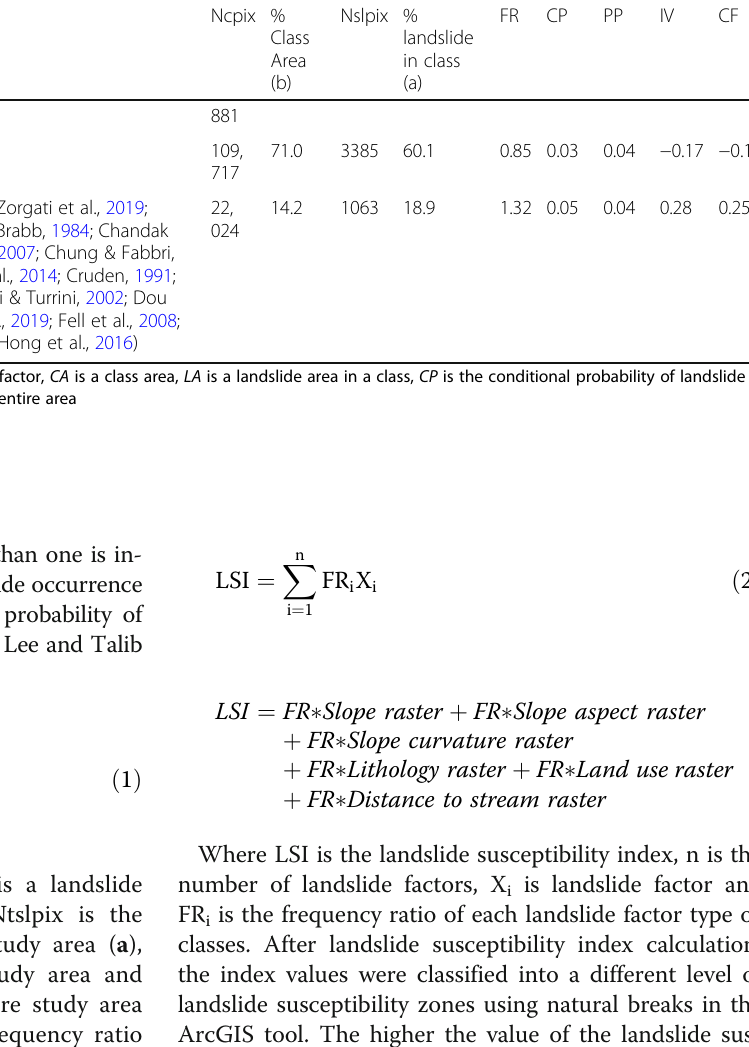
analysis. The landslide susceptibility index indicated the rence. The landslide susceptibility index (LSI) of the